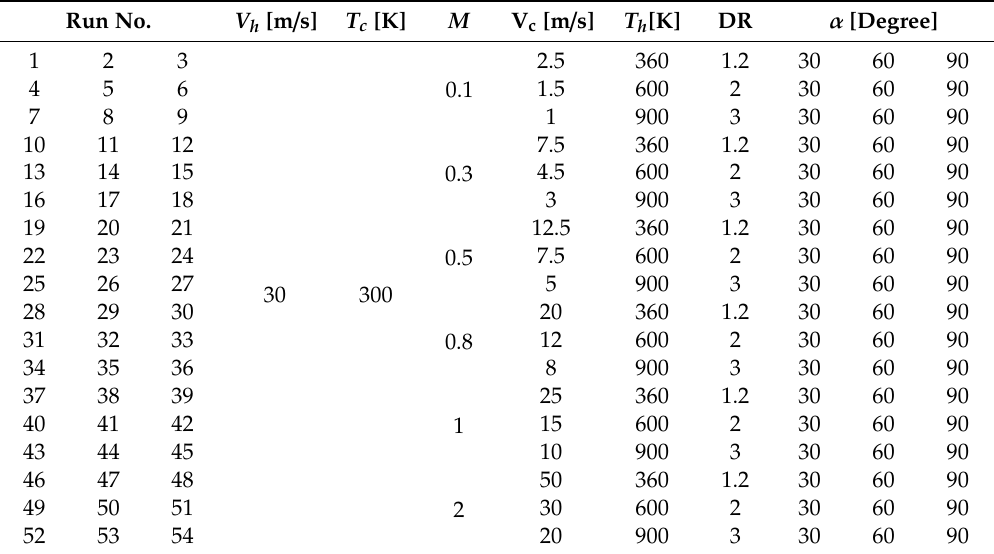
Table 2. Total of 54 numerical runs for di ff erent values of M , DR and α . Run